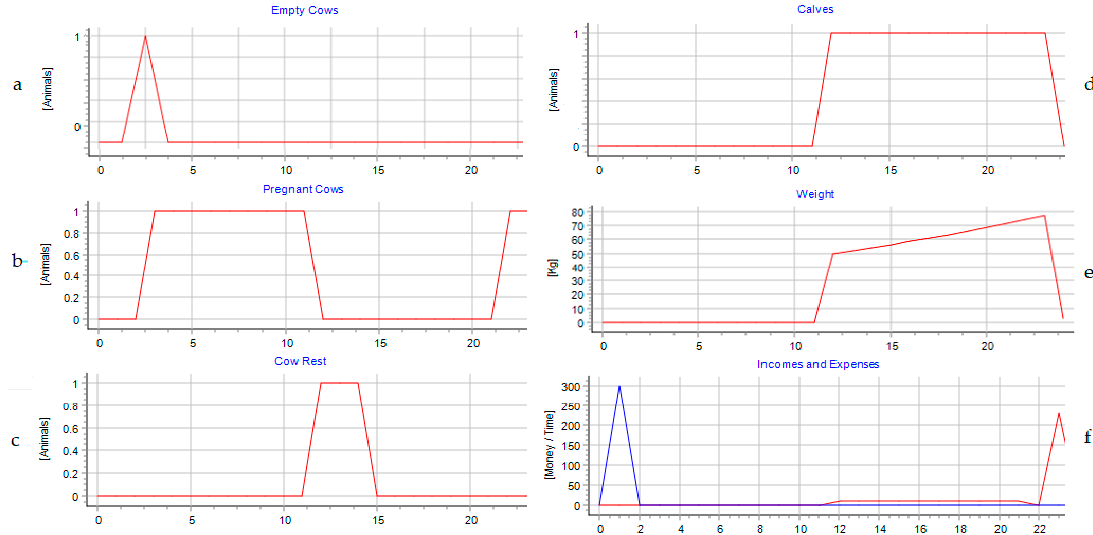
Figure 3. Behaviors of the empty, pregnant, at rest cows, calves, weight, incomes and expenses